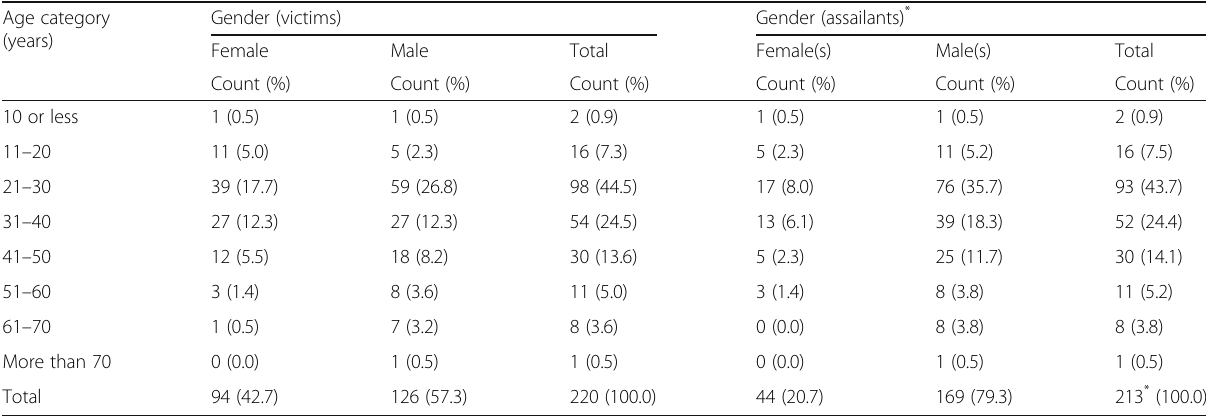
Table 1 The age and gender for the studied victims and assailants of the studied cases of non-fatal interpersonal violence Age category Gender (years)